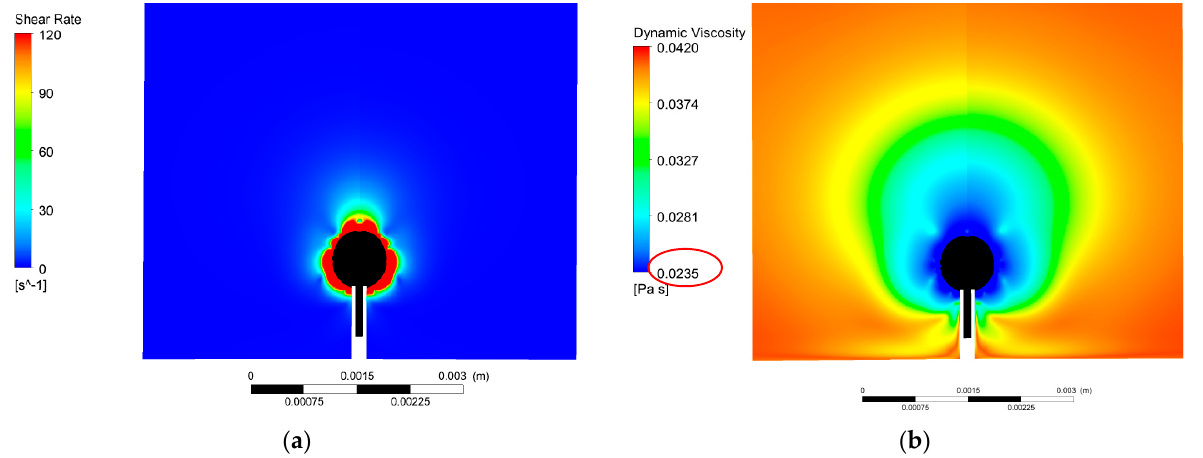
Figure 11. Distribution of ( a ) shear rate and ( b ) viscosity around a formed bubble (G2, Q = 1.09 × 10 − 6 m 3 /s).